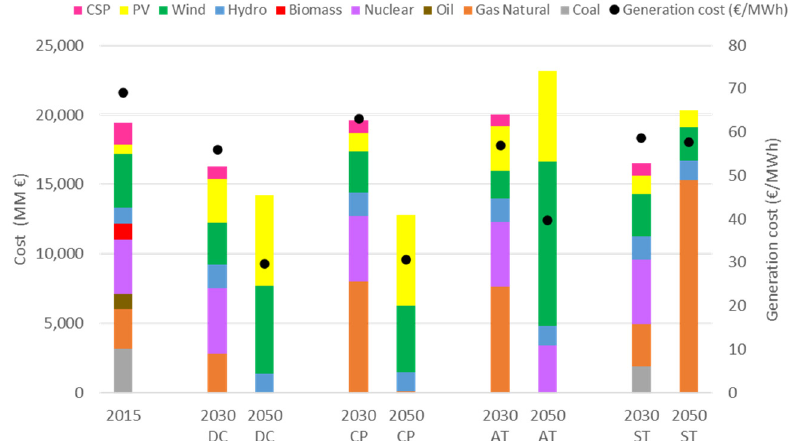
Figure 12. Power generation costs (LCOE) and contribution of different technologies in the four scenarios considered for 2030 and 2050 (DC = decarbonization; AP = maintaining current policies; AT = Advanced technologies; ST = stagnation).